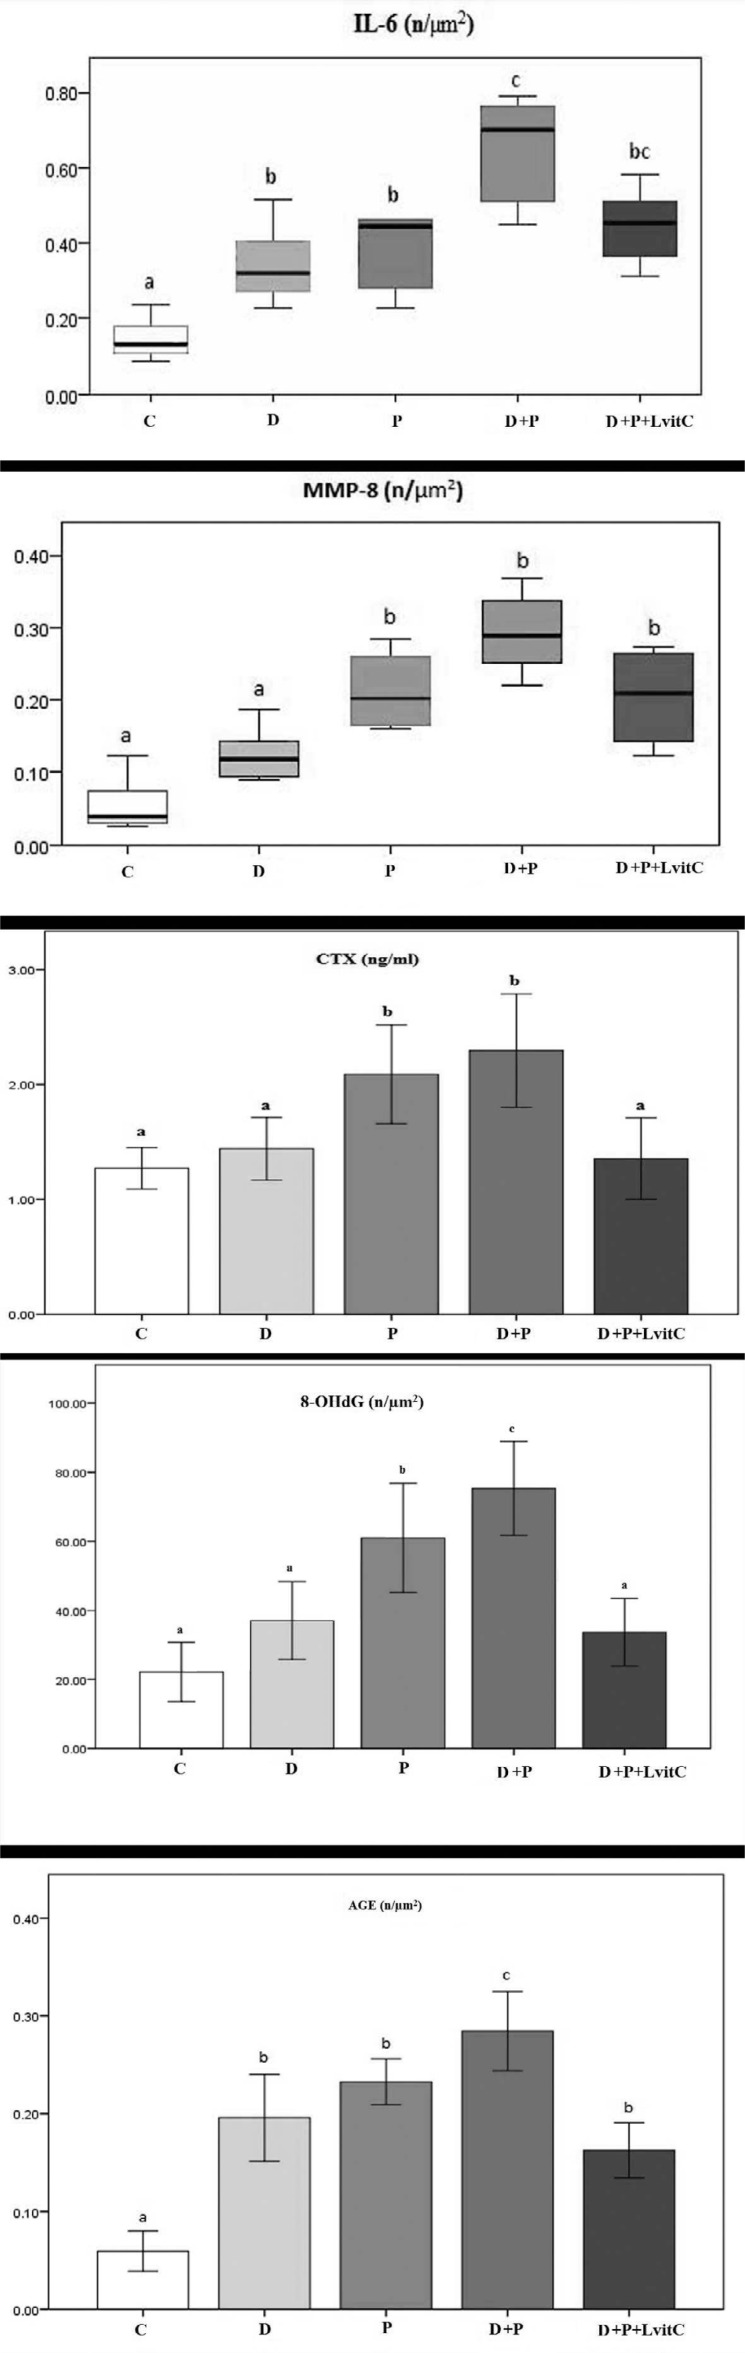
Comparison of the density values of anti-IL-6, anti-MMP-8, anti-8-OHdG, anti-AGE-positive cell per 1,000mm2 and serum CTX levels in all groups. Different lowercase letters (a,b,c) show statistical differences among groups (P<0.05)